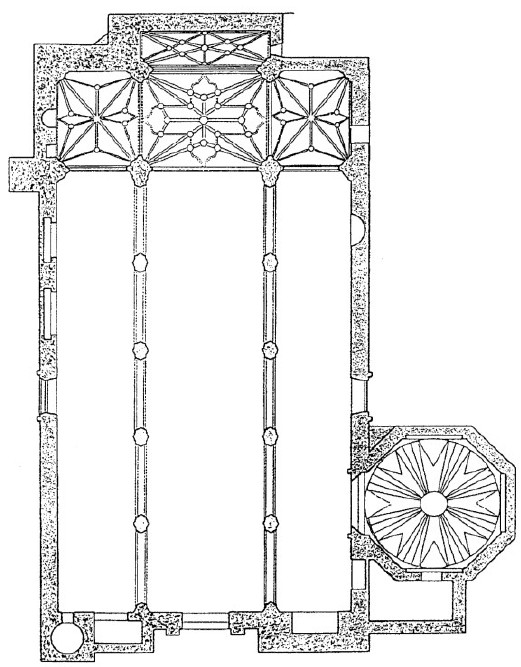
Figure 11. Floor plan. Parish church of San Mateo. Lucena (Cordoba). © Junta de Andalucía.